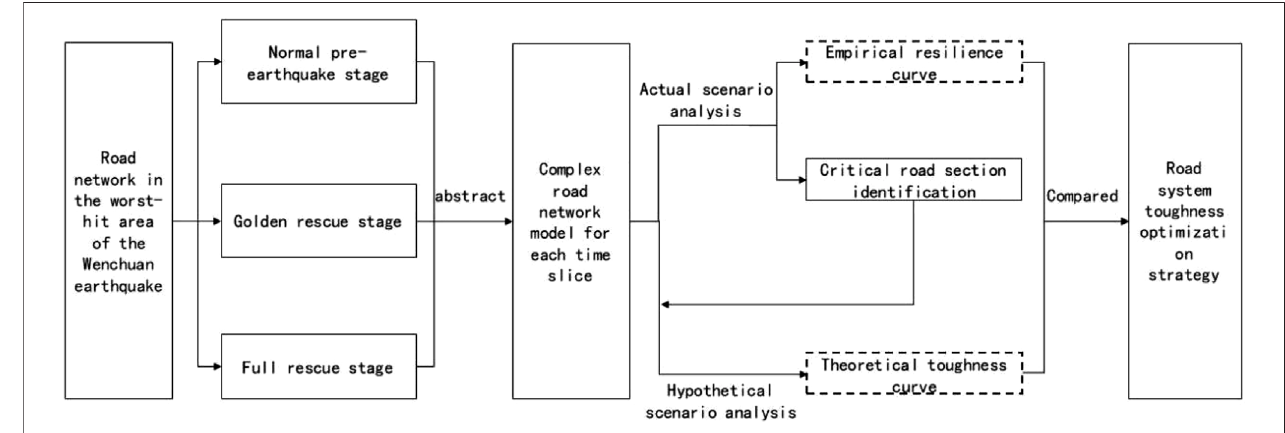
FIGURE 3 | Technical route.